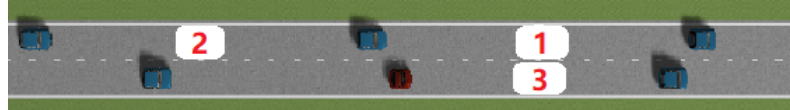
Figure 10. The traffic scenario of preparing for lane